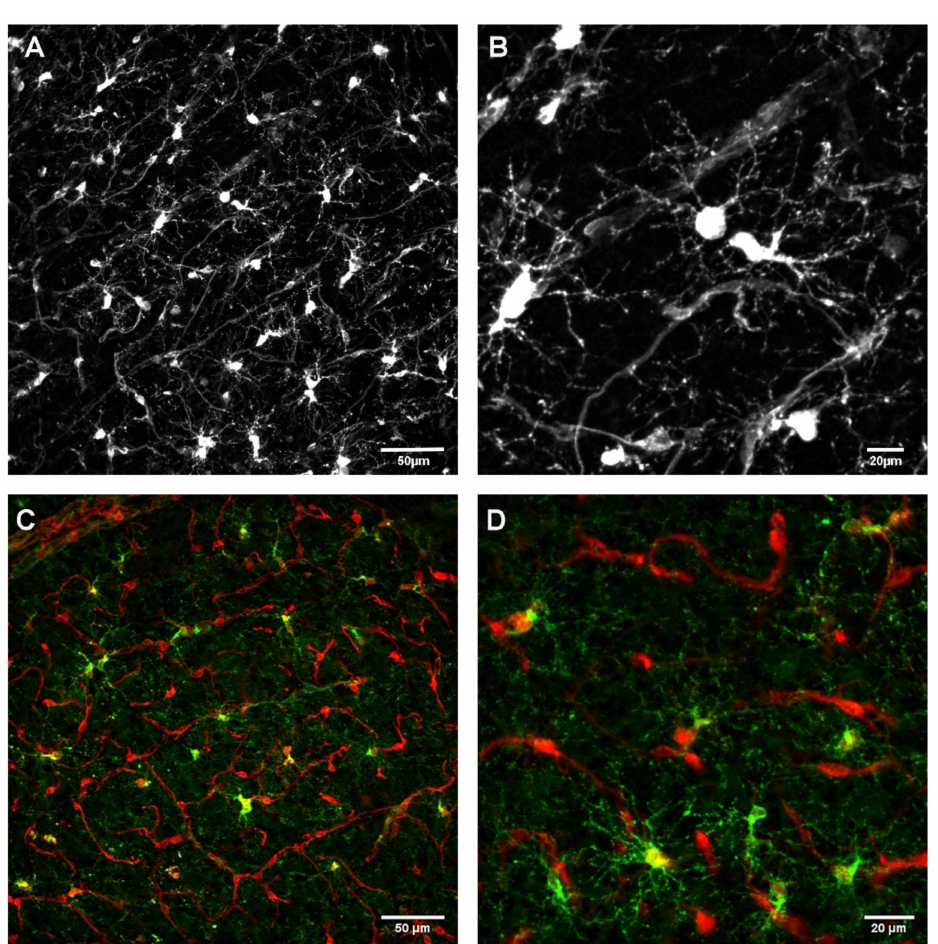
Figure 1. OPCs and the vasculature: numerous contact points are visible in the cortex of adult (P60) NG2DsRed transgenic mice. ( A , B ). Expression of a fluorescent marker (DsRed, staining intensified by an antibody detecting red fluorescent protein) under the control of the NG2 promotor reveals its distribution along the vasculature in the dense vessel network and numerous OPCs, distributed throughout the parenchyma in between the vessels. ( C , D ). Verification of OPCs by staining with PDGFR α in the cortex of an NG2DsRed mouse (P60). While vascular cells strongly express DsRed (see A and B) and mark the blood vessels in red, OPCs in the parenchyma additionally express PDGFR α (detected with an anti-PDGFR α antibody, shown in green). Therefore, the soma of the OPCs appears in yellow. Note the specific morphology of OPCs as opposed to vascular